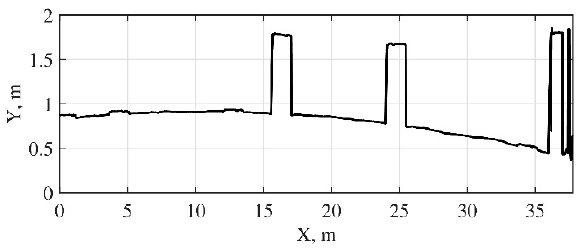
Figure 4. An example of a curvilinear route.